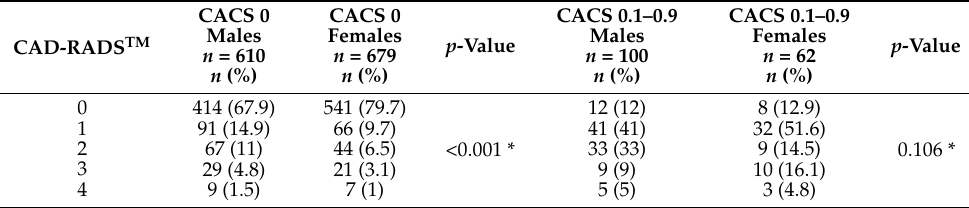
Table 2. Coronary computed tomography angiography (CTA) findings in patients with a coronary calcium score (CACS) of zero and with an ultralow CACS (0.1–0.9 AU) before propensity score matching ( n = 1451); Coronary Artery Disease – Reporting and Data System (CAD-RADS) TM —CTA stenosis severity.